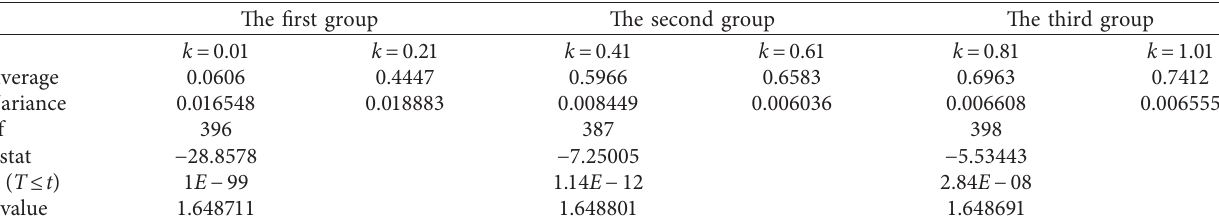
Figure 11: Influence of benefit overconfidence on product diffusion. Table 2: The sample t -test results.